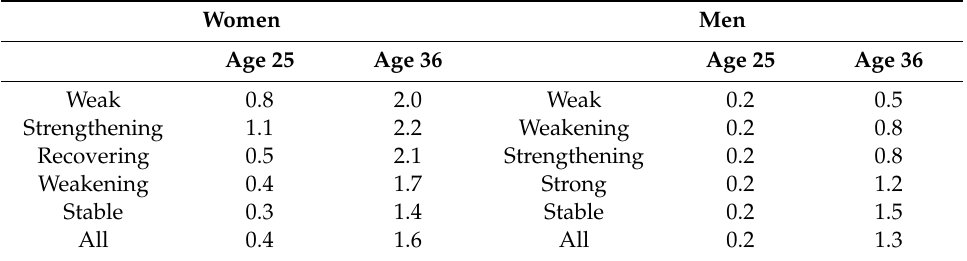
Table 2. Average number of children at the age of 25 and 36 by